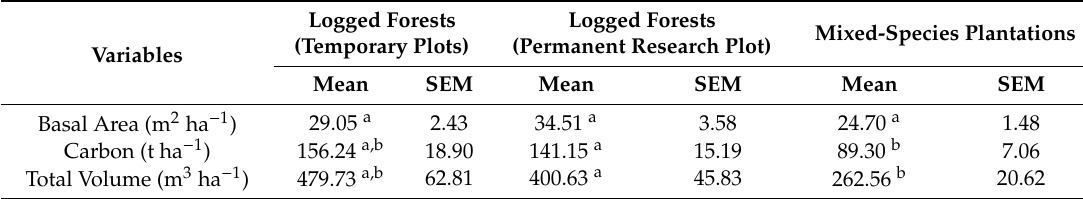
Table 4. Basal area, carbon stock and volume of the three study